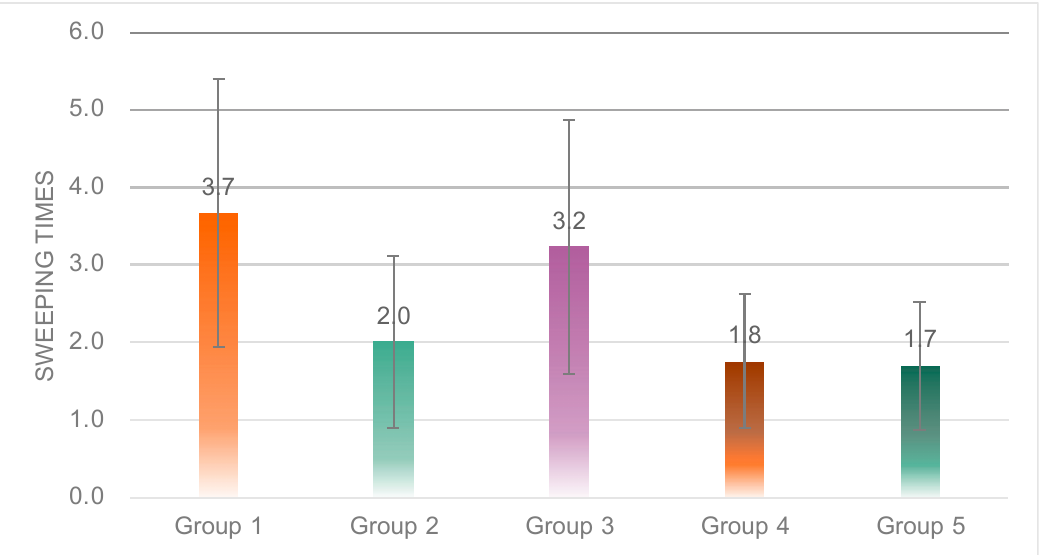
Figure 19. Individual differences in the total sweep times of the five groups.